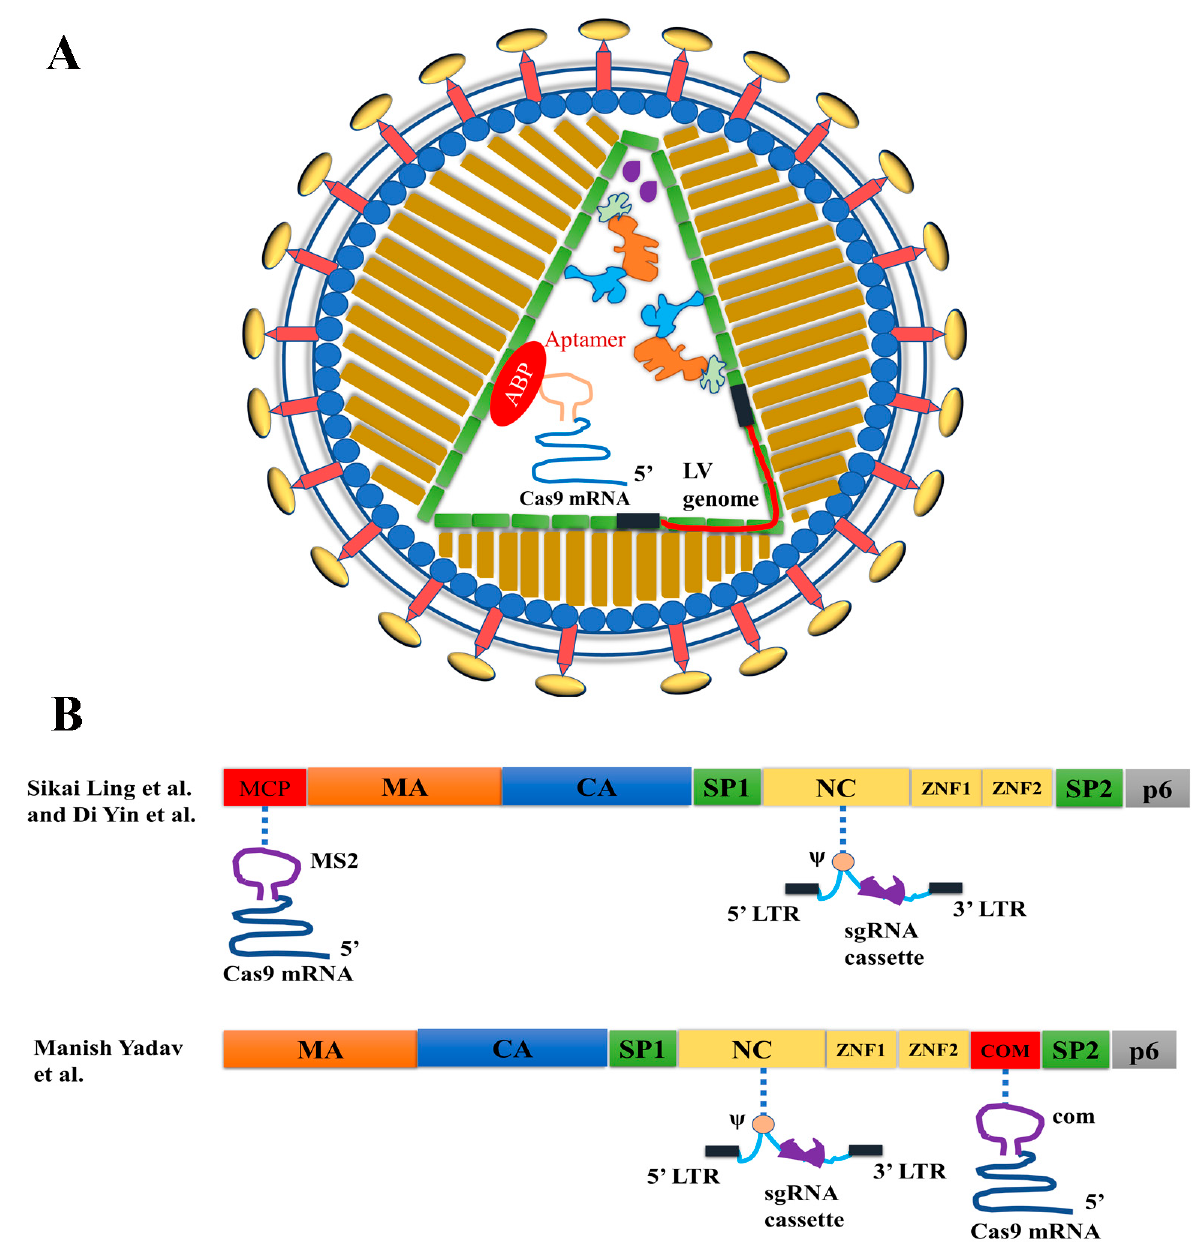
Figure 4. Strategies for modifying the Gag protein for mRNA and sgRNA delivery by VLP/LV hybrid particles. ( A ) Diagram illustrating mRNA- and sgRNA-co-delivery of VLP/LV hybrid particles. The mRNAs can only serve as the templates for translation since they do not contain viral sequences necessary for reverse transcription, so reverse transcription cannot happen. ( B ) Different approaches to Gag modification for Cas9-mRNA and sgRNA-expression cassette co-delivery. The VLPs were reported in references [6], [7] and [13].